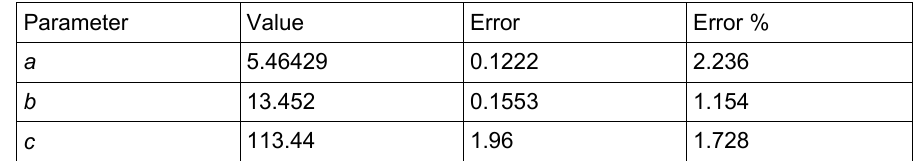
Table 1 – Fit parameters for the peak in Figure 2